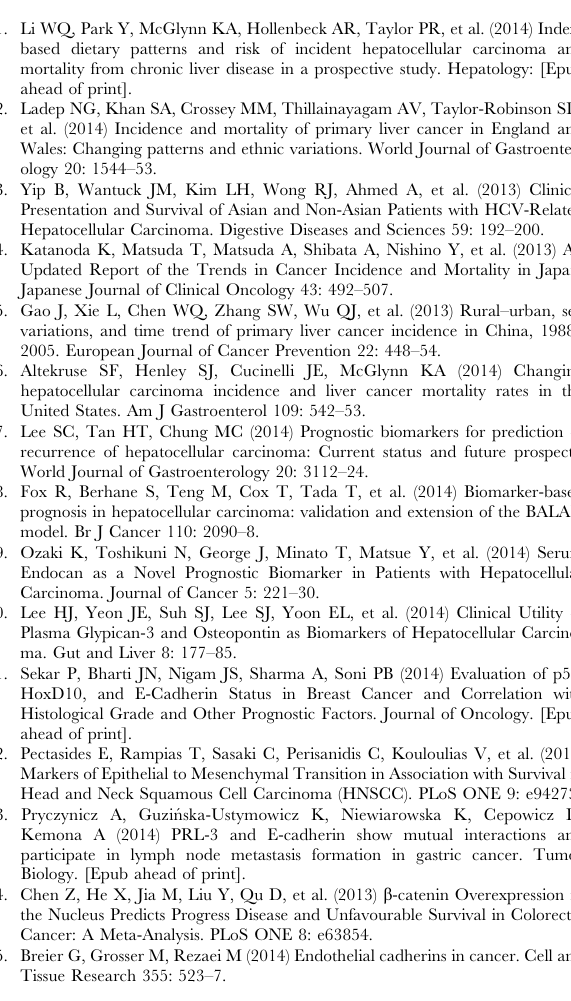
Figure S7 Funnel plot to assess publication bias. Begg’s publication bias plot showed no publication bias for studies